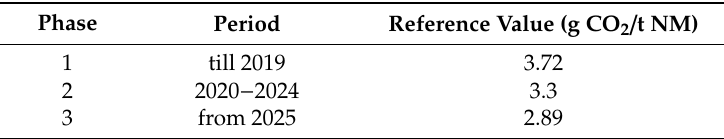
Table 11. Reference values for EEDI regulation for an Aframax